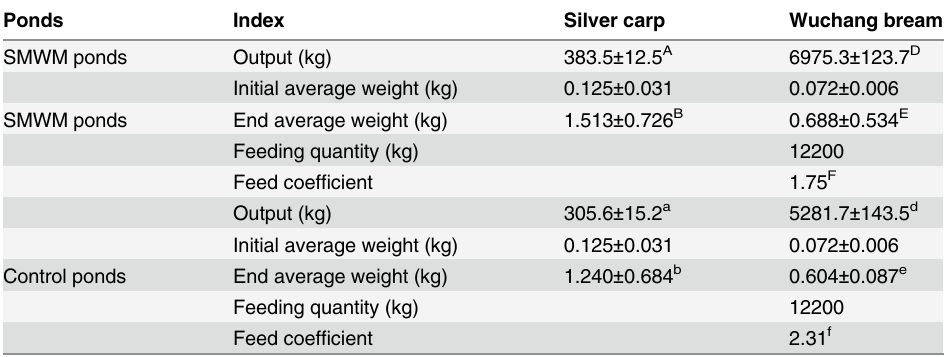
Note: The same letter in table with capital and lowercase shown there were signi fi cant differences ( P <